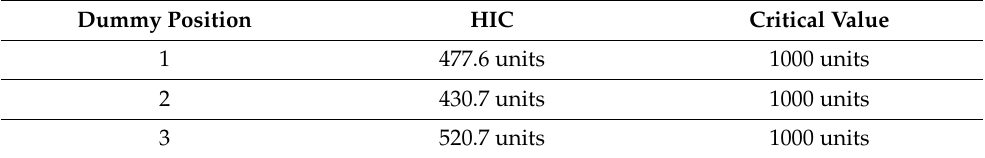
Table 12. Summary of Test 3: HIC injury criteria values.